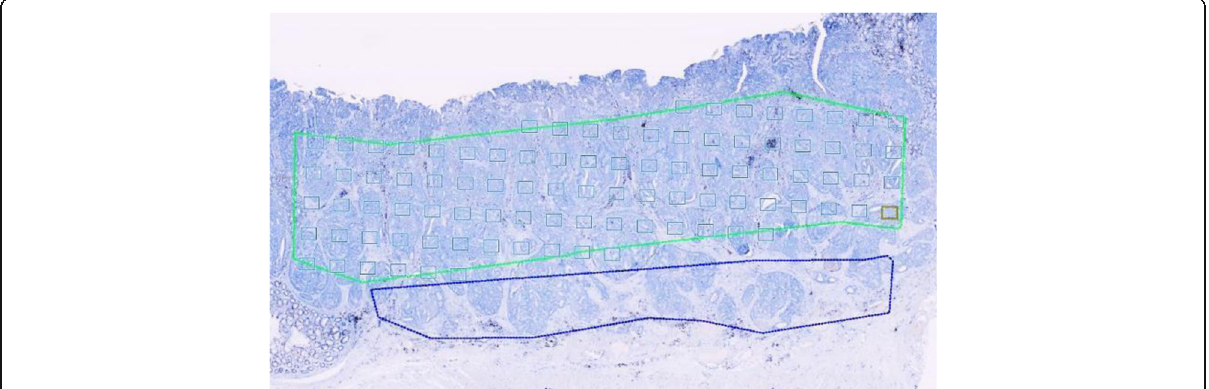
Fig. 3 Systematic, uniform random sampling of fields of vision using newCAST software. The yellow frame represents the current field of vision